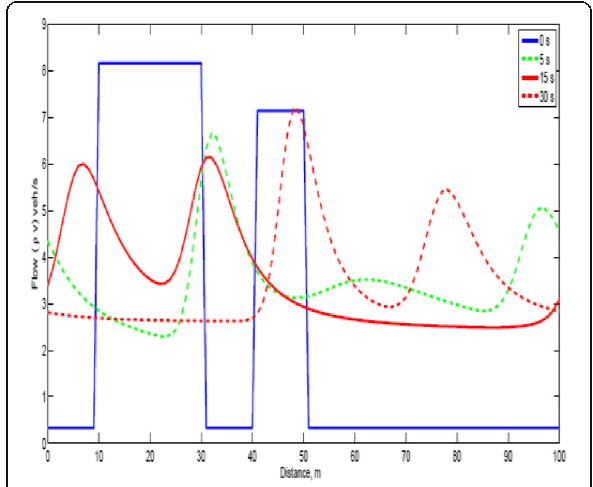
Fig. 9 The proposed model flow with b = 2